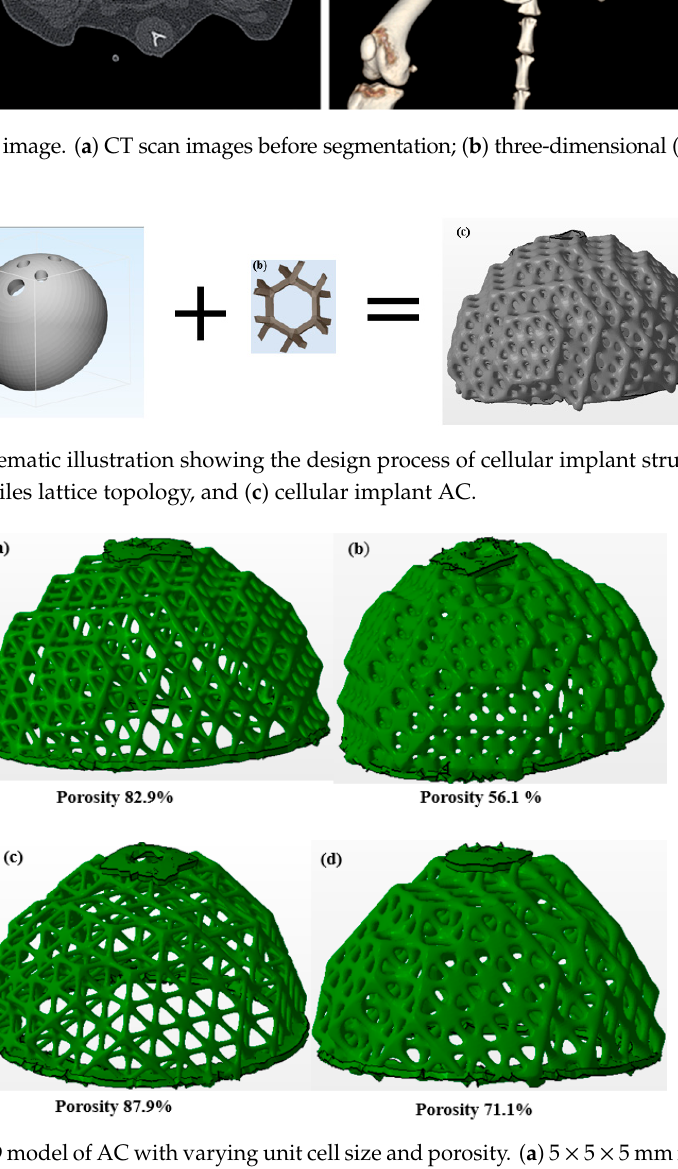
Figure 5. 3D CAD model of AC with varying unit cell size and porosity. ( a ) 5 × 5 × 5 mm non-optimized, ( b ) 5 × 5 × 5 mm optimized, ( c ) 6 × 6 × 6 mm non-optimized, and ( d ) 6 × 6 × 6 mm optimized.